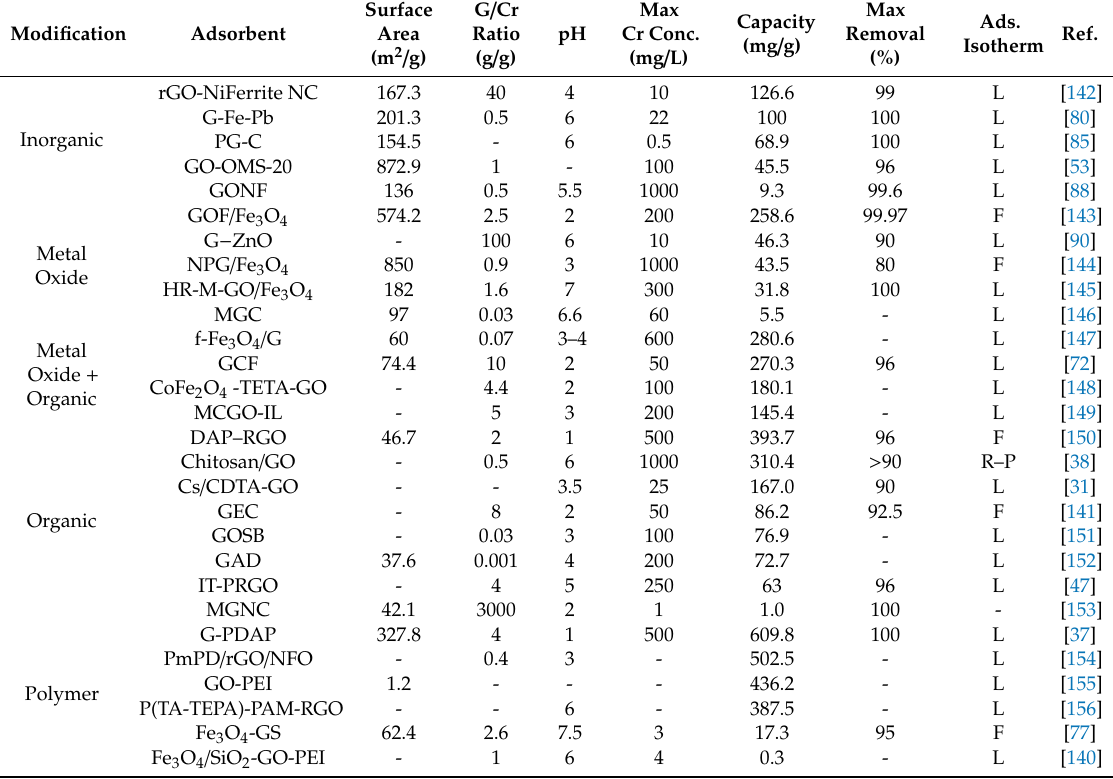
Table 7. Adsorption properties of di ff erent GO-based adsorbents used in removal of Cr (IV)